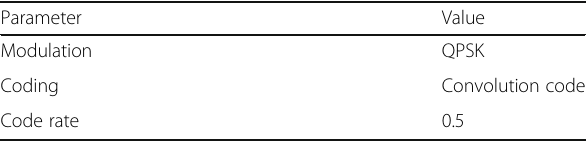
Table 1 Modulation and coding parameters